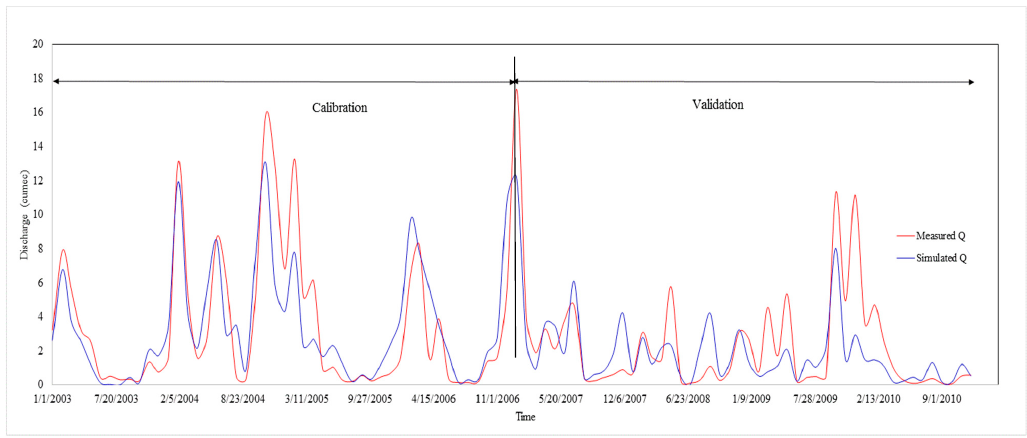
Figure 2. Calibration and Validation of Saline Bayou Watershed. Calibration statistics: NSE = 70%, PBIAS = 0.00, RMS = 0.55, and R 2 = 0.70. Validation statistics: NSE = 59%, PBIAS 198 = 0.21, RMS = 0.64, and R 2 = 0.64). NSE: Nash–Sutcli ff e E ffi ciency; PBIAS: percent bias; RMS: ratio of root mean square error; R 2 : Coe ffi cient of Determination. Dates are presented in the (month / day / year)